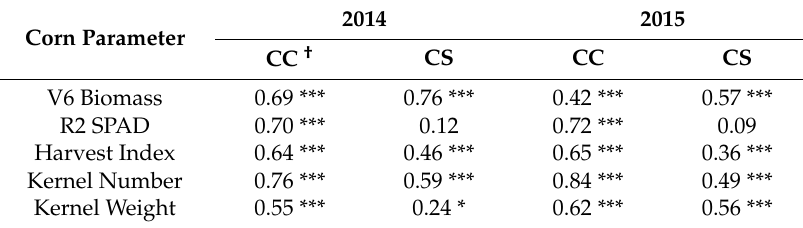
Table 7. Pearson correlation coefficients and associated significance level for final grain yield between selected corn growth parameters as influenced by crop rotation and averaged across all other treatments. Corn